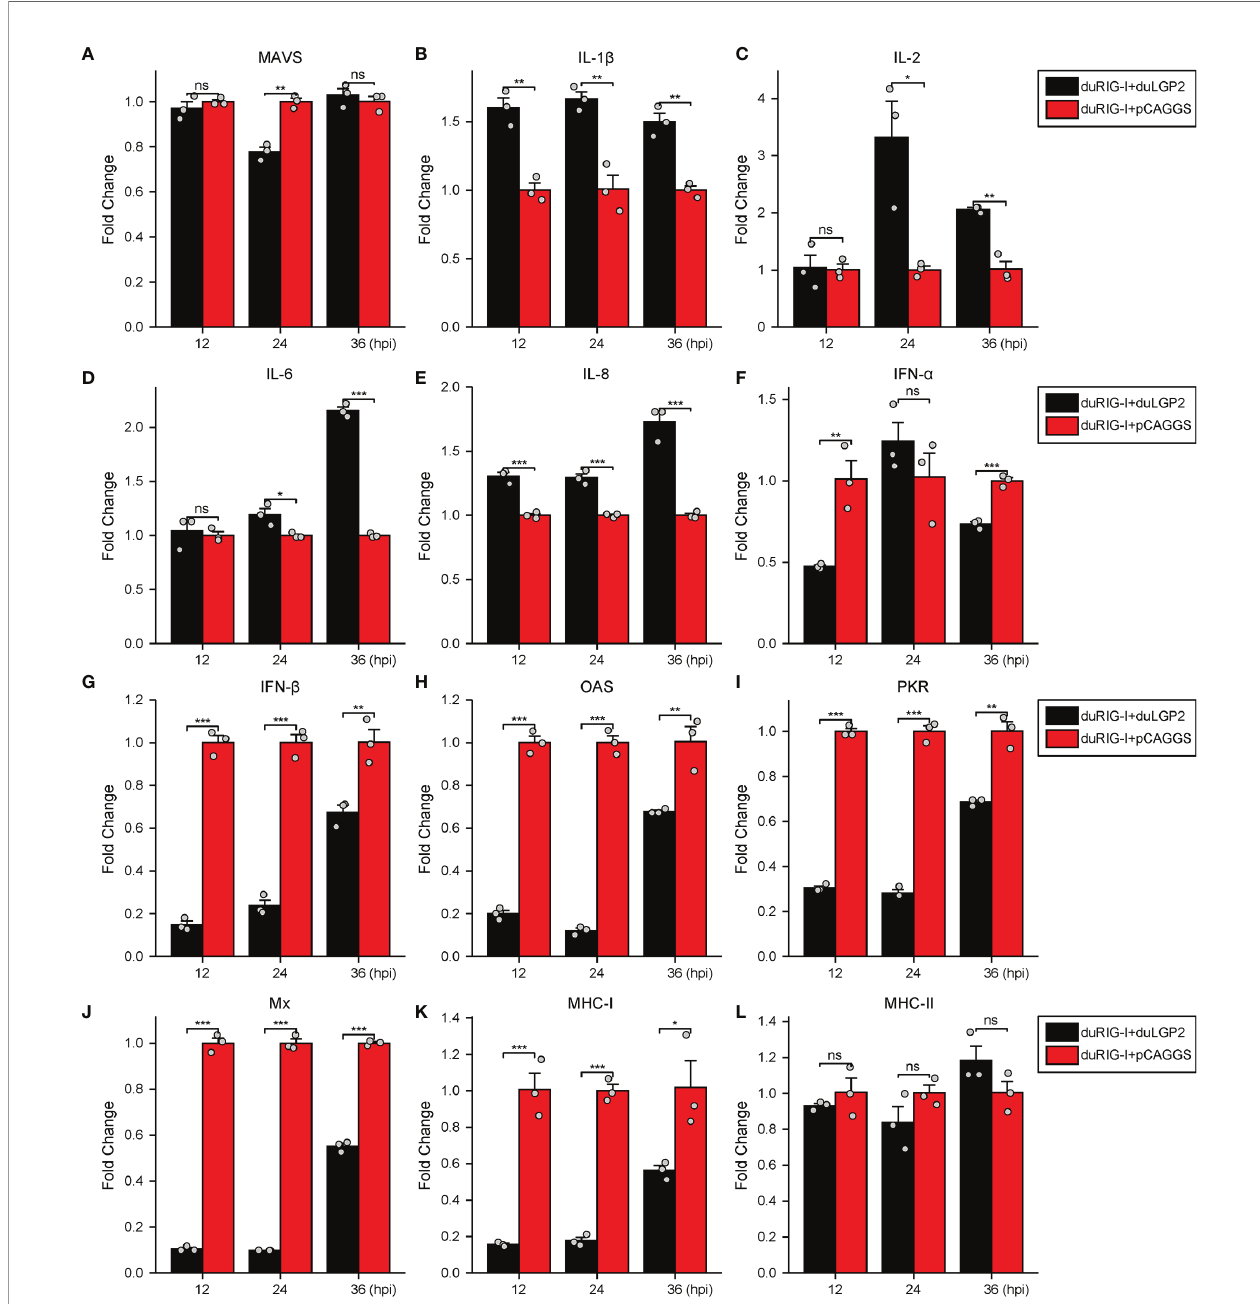
FIGURE 7 | duLGP2 regulates duRIG-I-mediated cytokine expression during DTMUV infection. DEF cells were transiently co-transfected with indicated expression plasmids or empty plasmids pCAGGS. Cells were infected with DTMUV at 24 hpt and collected for analysis of cytokine detection at different time points. (A) MAVS (B) IL-1 b (C) IL-2 (D) IL-6 (E) IL-8 (F) IFN- a (G) IFN- b (H) OAS (I) PKR (J) Mx. (K) MHC-I (L) MHC-II. The relative expression of gene mRNA was calculated using the 2 − DD Ct method with GAPDH serving as a normalization gene and mean control values as a baseline reference, and the values in the control groups (pCAGGS